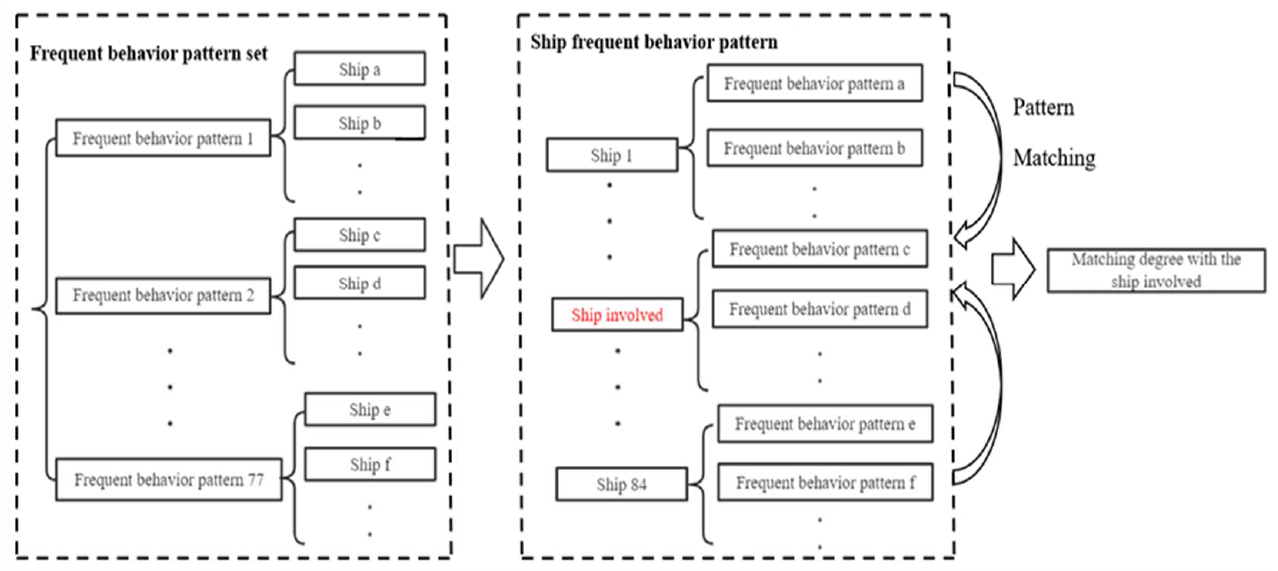
Figure 12. Flow chart of ship frequent behavioral pattern matching.